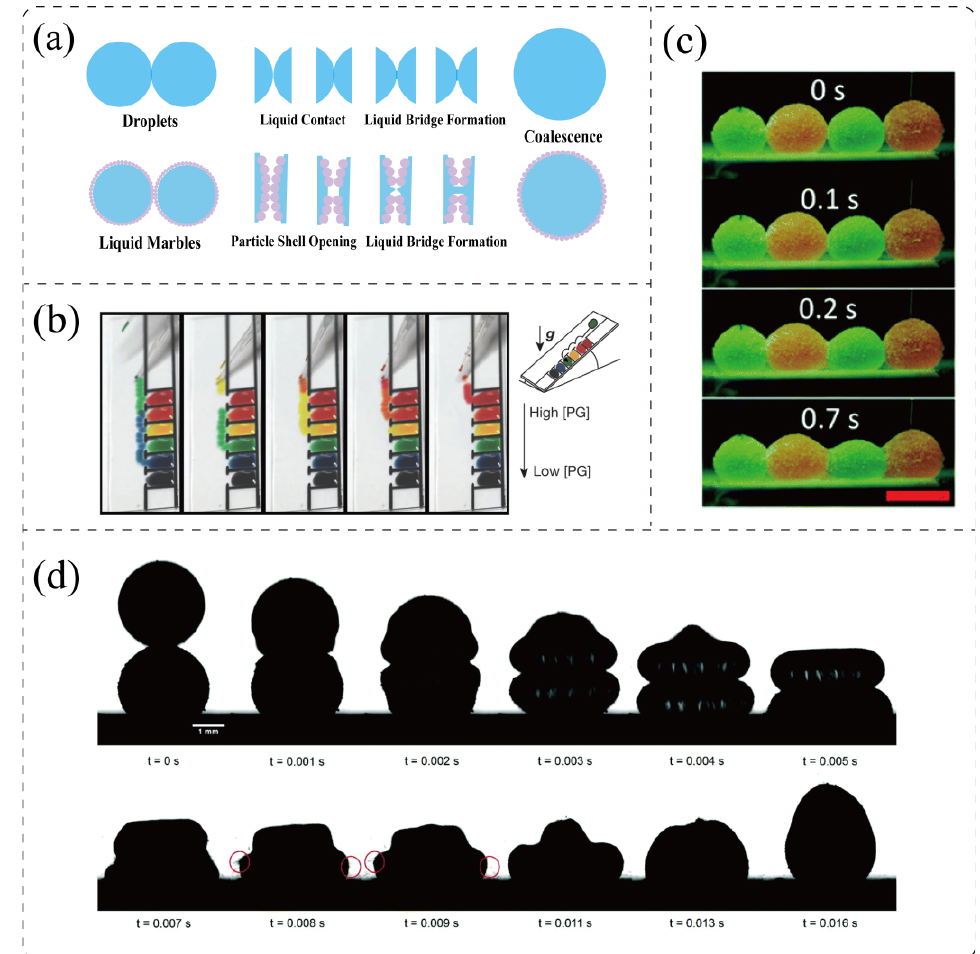
Figure 12. ( a ) The coalescence processes of droplet-to-droplet and LM-to-LM. ( b ) The merging of droplets with a similar concentration after passing through other droplets under gravity [89] (Reproduced with permission from Springer Nature, 2015). ( c , d ) Different fusion processes of LMs under the action of electric force and gravity, respectively. The red circles outline the particle aggregates ejected in vertical marble collisions [133,134] (Reproduced with permission from Royal Society of Chemistry, 2017 and 2018, respectively).